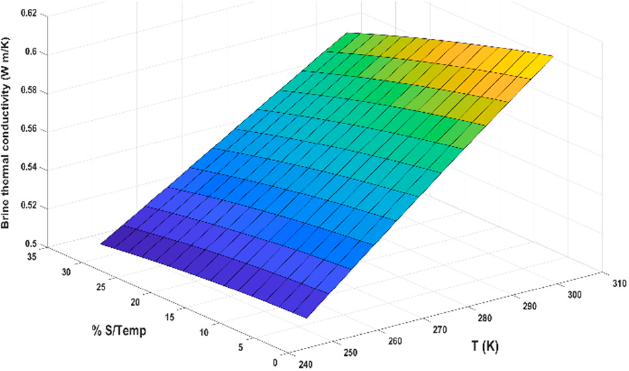
Figure 3. Brine thermal conductivity as a function of salinity and temperature (See Appendix A).